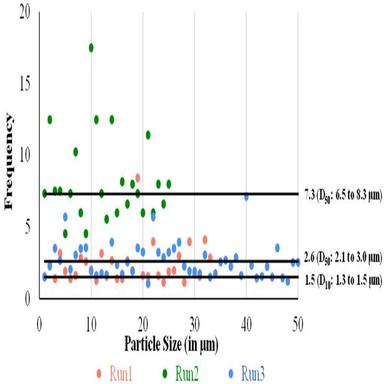
D-statistic based attribute control chart and control strategy utilizing Bowley's seven-figure non-parametric summary statistics.